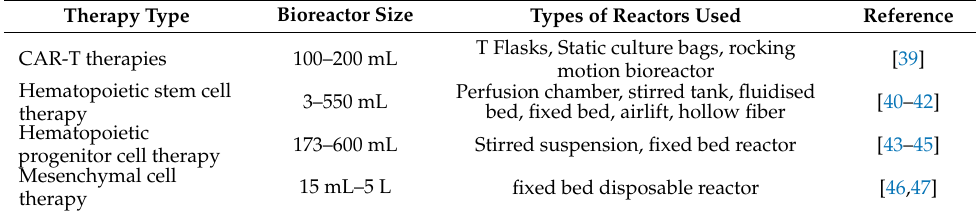
Table 1. Types of bioreactors used in cell therapy studies.